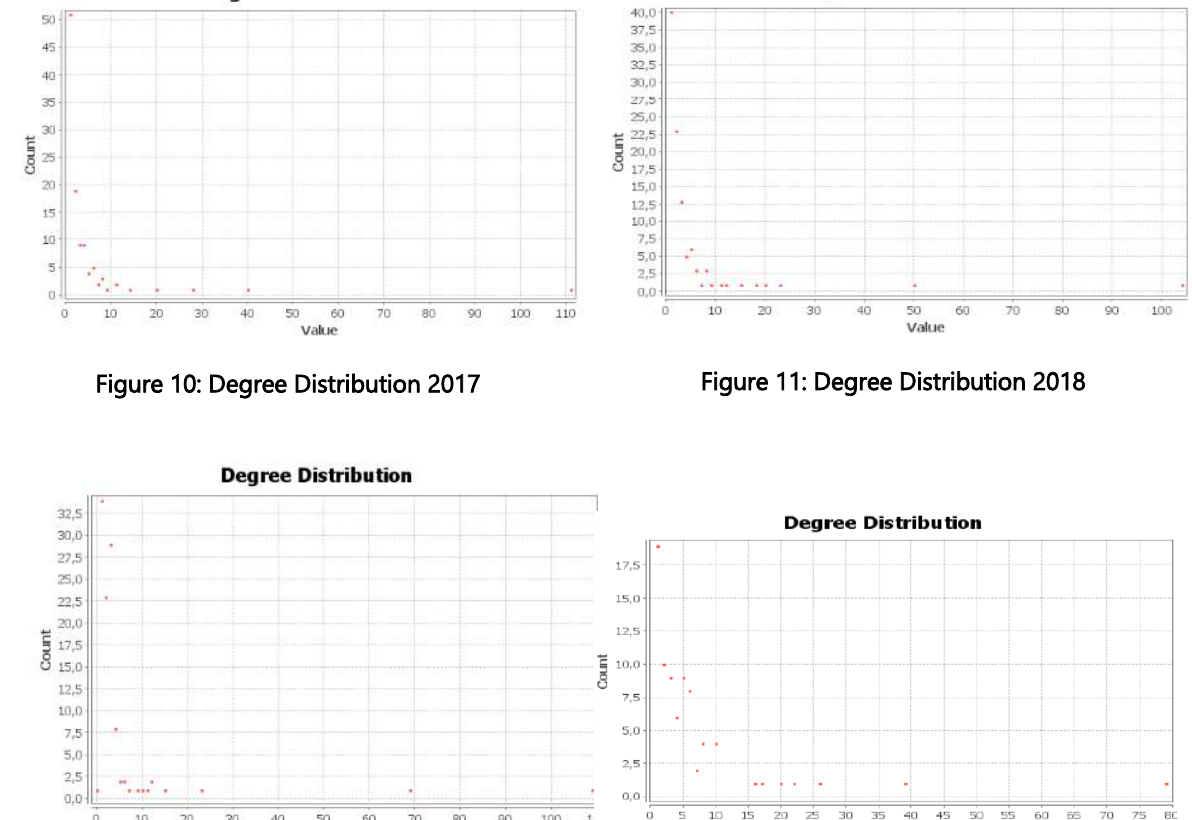
Figure 12: Degree Distribution 2019 Figure 13: Degree Distribution